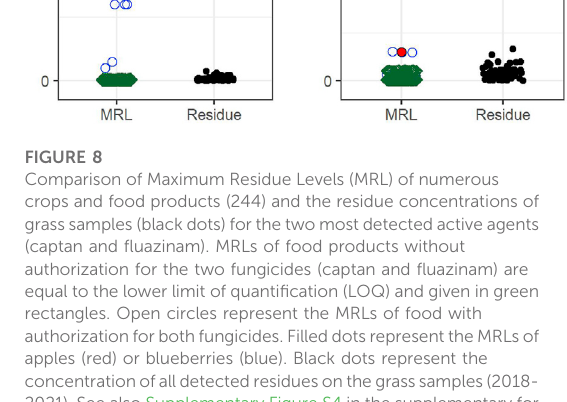
2021). See also Supplementary Figure S4 in the supplementary for other active